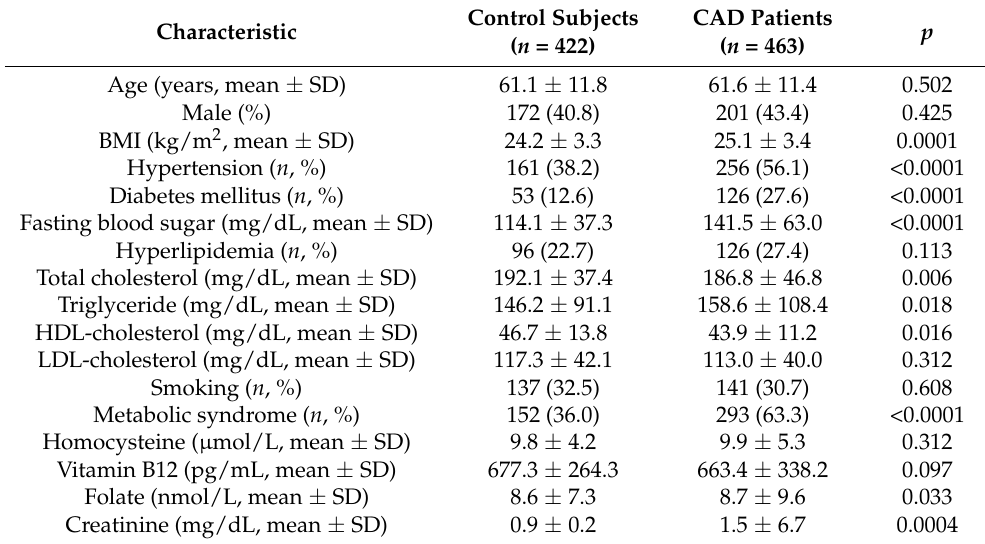
Table 1. Baseline characteristics between CAD patients and control subjects.